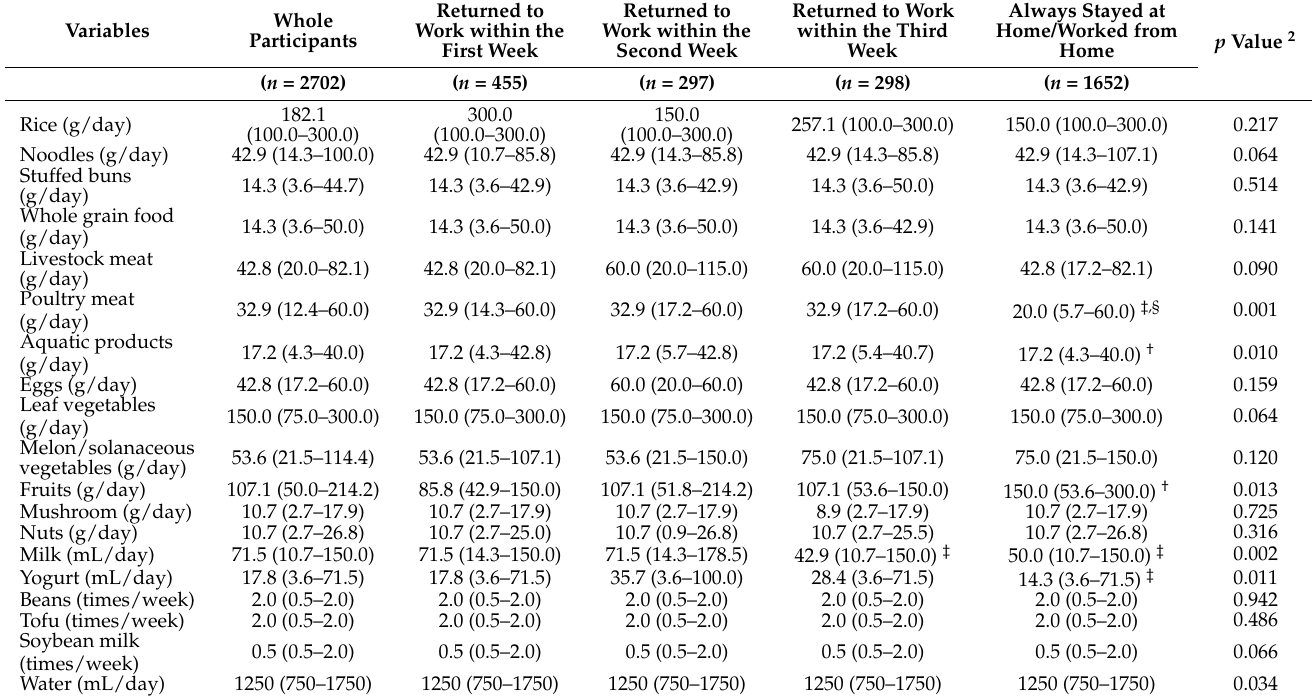
Table 3. Food intake during the COVID-19 lockdown by status 1